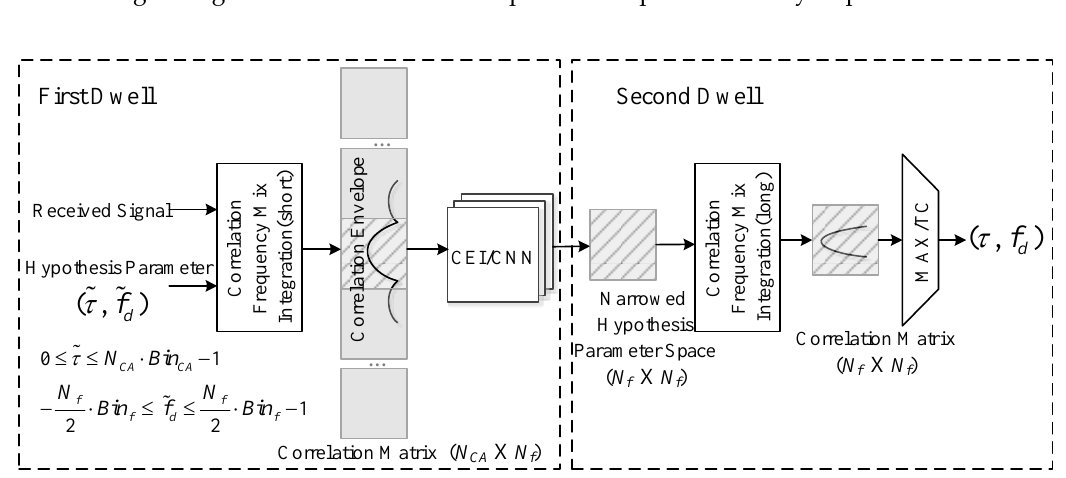
Figure 2. Double dwell acquisition architecture.